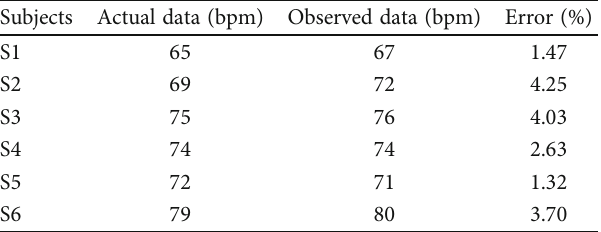
Figure 2: Deviation of data in room Table 3: Smart healthcare monitoring system using IoT. Table 5: Collection of room humidity through the actuarial machine and the observed system.